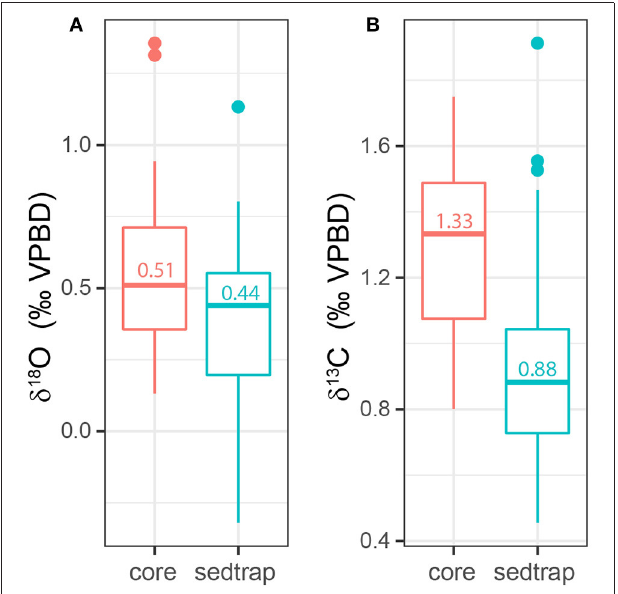
FIGURE 7 | Box and whisker plots showing the difference between (A) the δ 18 O and (B) δ 13 C measurements of H. inflatus specimens from the sediment trap (blue) and the core (red). Both δ 18 O and δ 13 C values are higher in the core material than in the sediment trap. Median values are written inside each box.